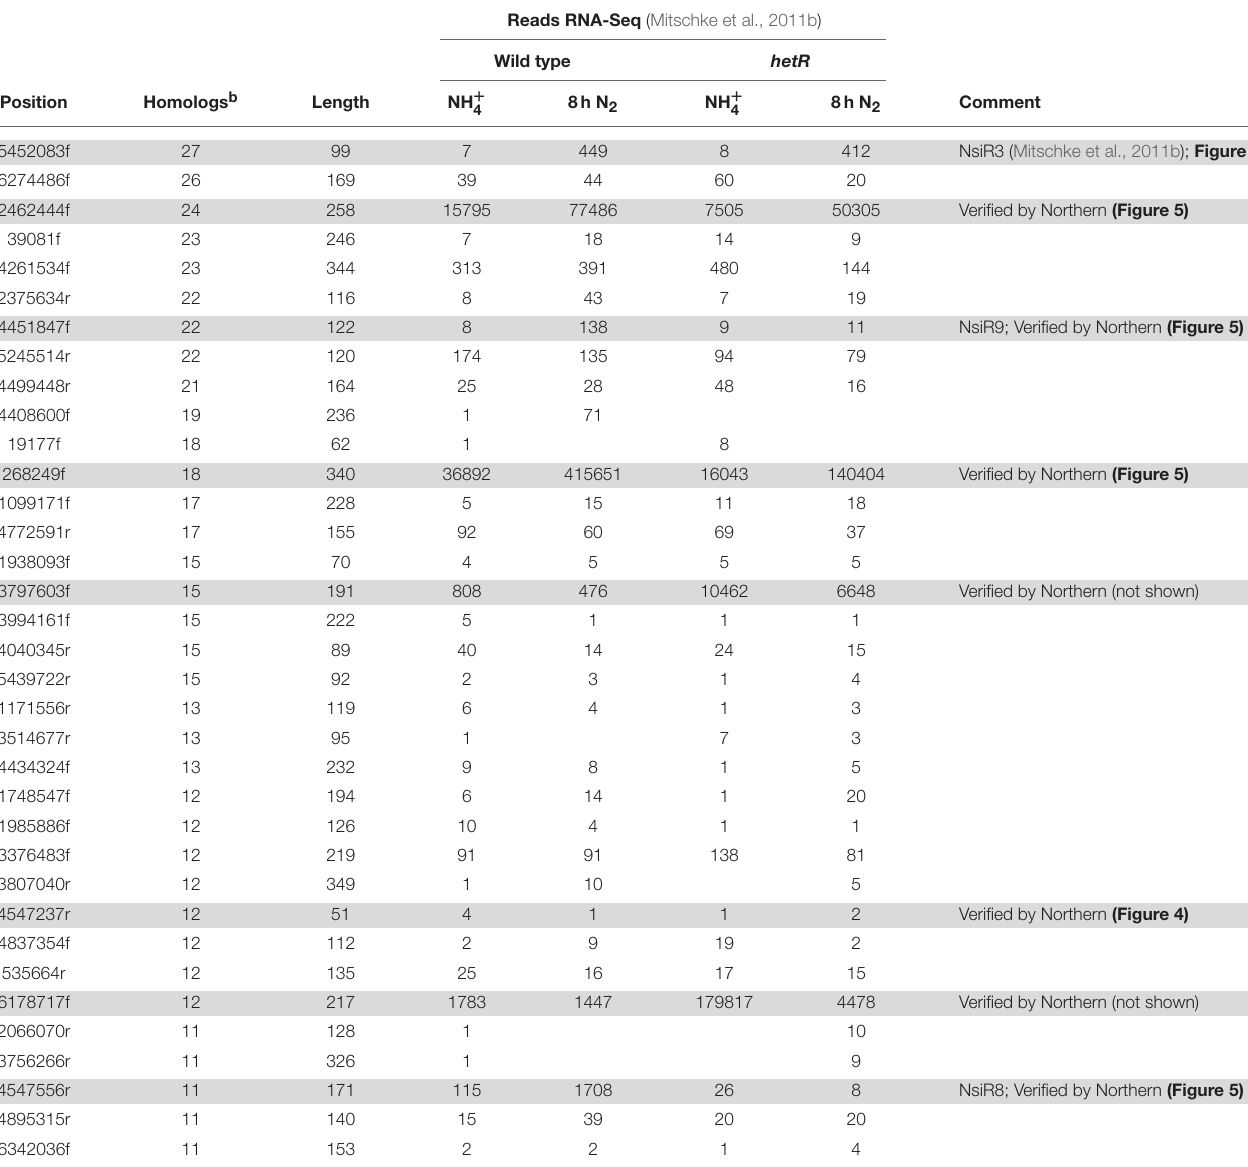
TABLE 1 | Selected a predicted sRNAs from Nostoc sp. PCC 7120 with homologs in some of the 27 genomes of heterocyst forming cyanobacteria. Reads RNA-Seq (Mitschke et al., 2011b) Wild type